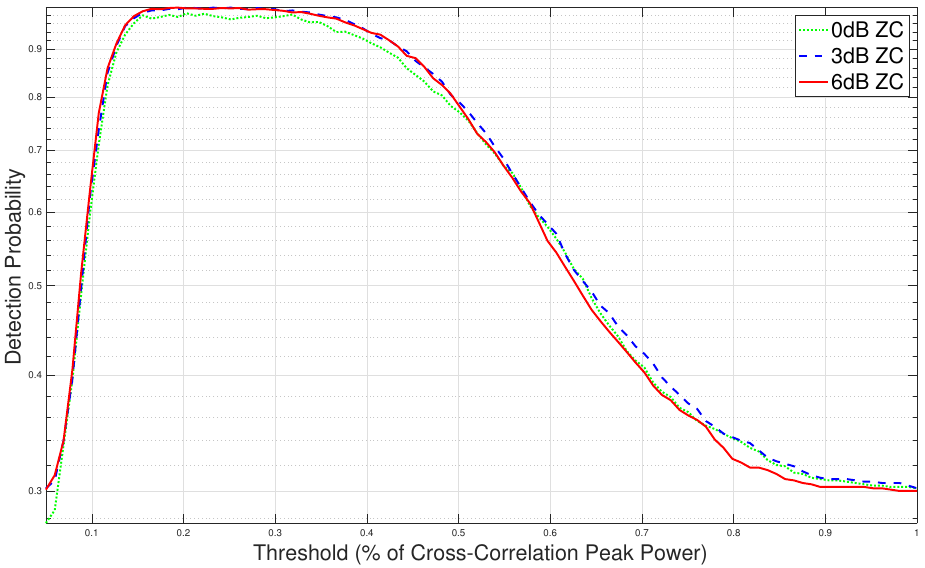
Figure 4. Correct frame detection probability as function of cross-correlation threshold value for peak